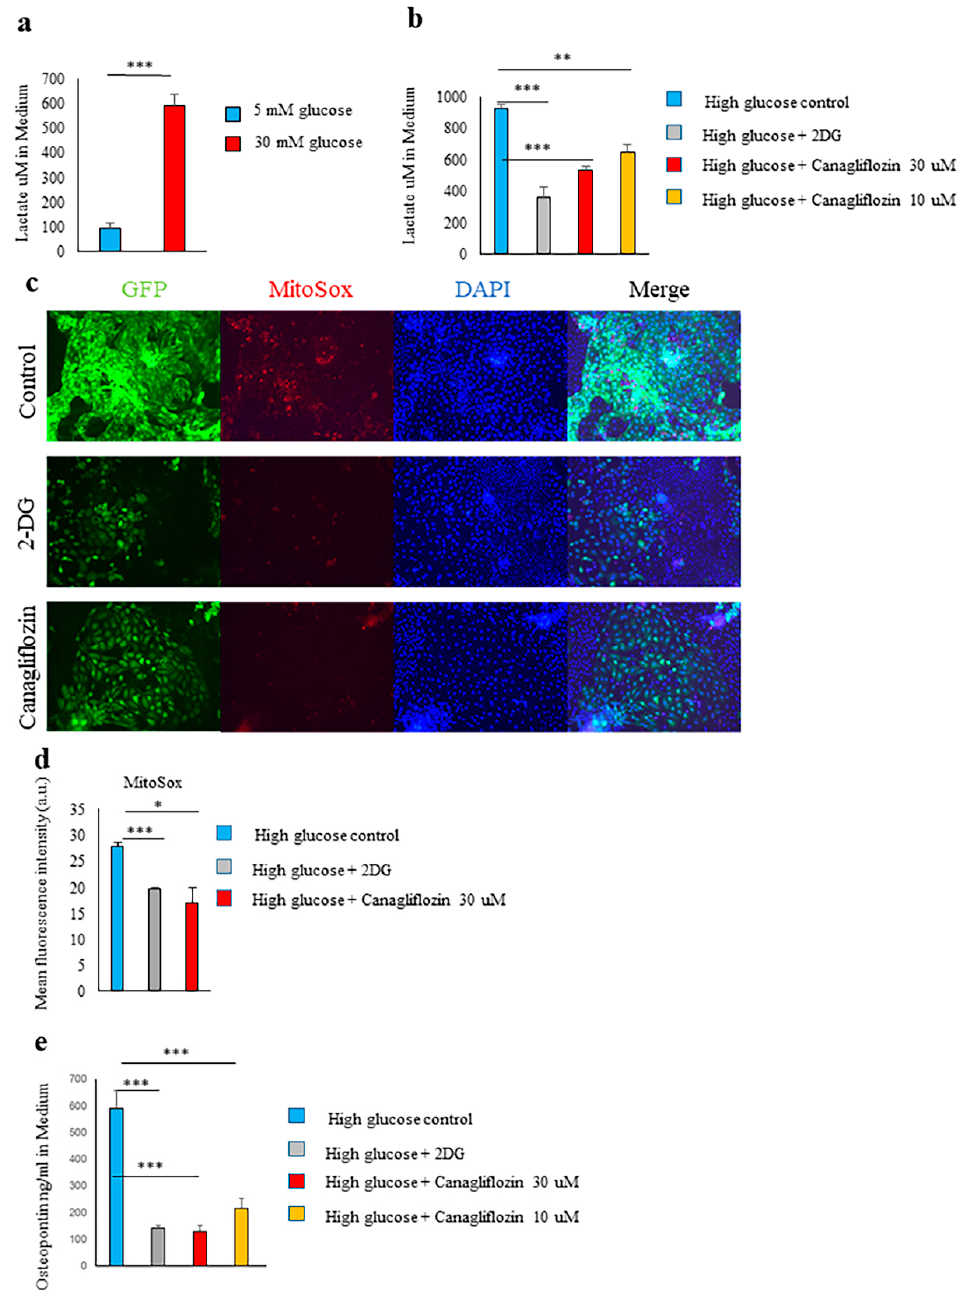
Figure 4. Canagliflozin ameliorated the upregulation of Spp1 transcriptional activity. ( a ) Primary culture of proximal tubular epithelial cells (PTEC) derived from enhanced green fluorescent protein (EGFP)- Spp1 knock-in reporter mice. PTEC were cultured in 5 mM (“low”) or 30 mM (“high”) glucose conditions for 7 days. Lactate in the culture supernatants was assessed by enzyme-linked immunosorbent assay (ELISA; n = 6 per group). ( b – d ) Primary culture of PTEC derived from EGFP- Spp1 knock-in reporter mice. PTEC were cultured in 30 mM glucose conditions for 7 days with 50 mM 2-deoxy-D-glucose (2-DG), 30- µ M canagliflozin, 10- µ M canagliflozin, or control regent. ( b ) Lactate in the culture supernatants was assessed by ELISA ( n = 6 per group). ( c ) Analysis of fluorescence microscopy showed 4 (cid:48) ,6-diamidino-2-phenylindole (DAPI) and MitoSOX staining and of EGFP- Spp1 expression. ( d ) Mean fluorescence intensity of MitoSox in PTEC ( n = 3–5 per group). ( e ) Osteopontin (OPN) in the culture supernatants was assessed by ELISA ( n = 6 per group). * p < 0.05, ** p < 0.01, *** p < 0.001. Data are shown as means, and error bars depict